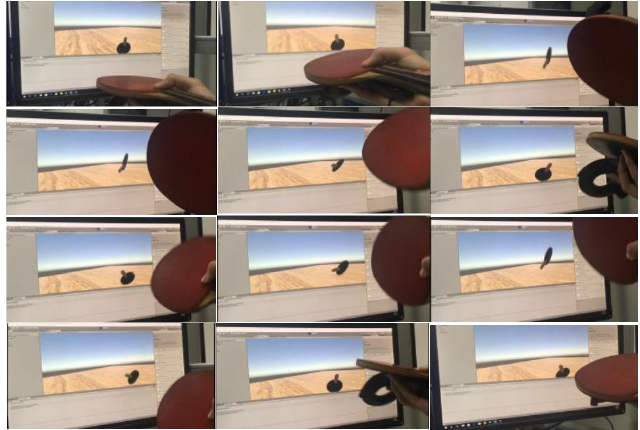
Figure 18. All of figures show experimental results of interactive realtime.